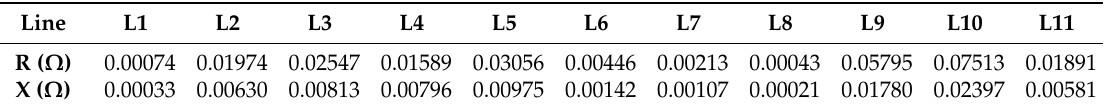
Table 1. Line impedances for the LV test